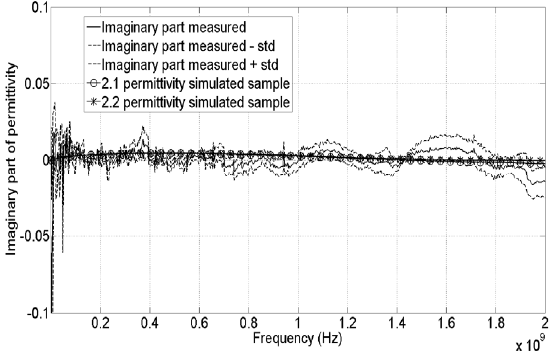
Figure 10. Imaginary part of the permittivity of Teflon measured and simulated with core radius a = 6.5 mm. The same measurement and simulation procedures are applied with the 1.2 mm core radius probe on the same Teflon